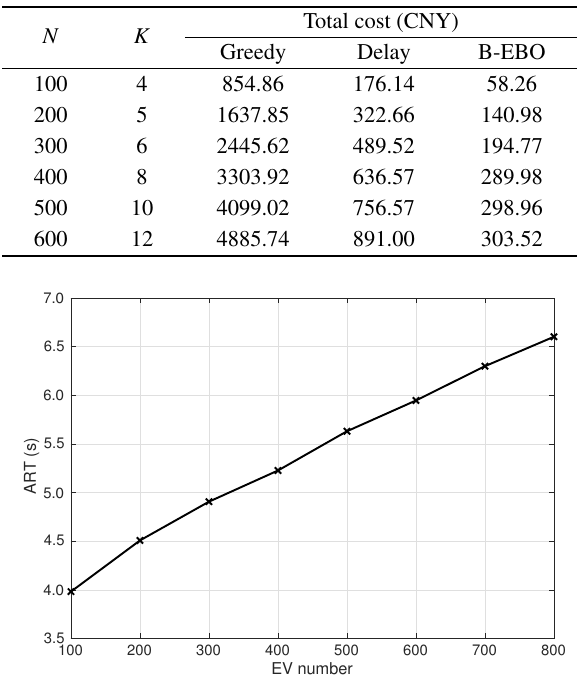
Fig. 5 Simulation results of every hour. Table 4 Total cost (CNY) with different N and K .